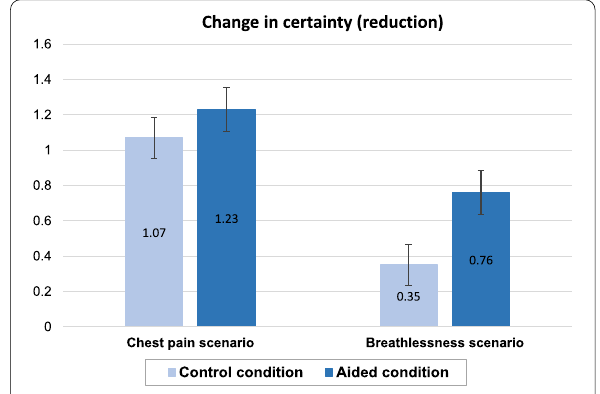
Fig. 1 Mean change in certainty by condition and